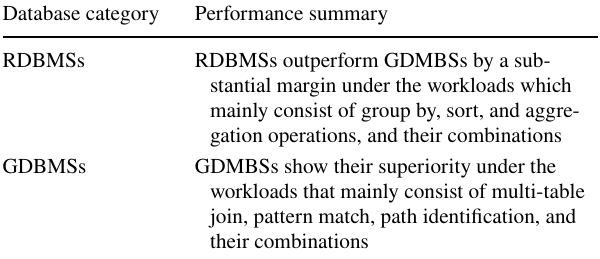
Table 11 The comparisons between RDBMSs and GDBMSs Database category Performance